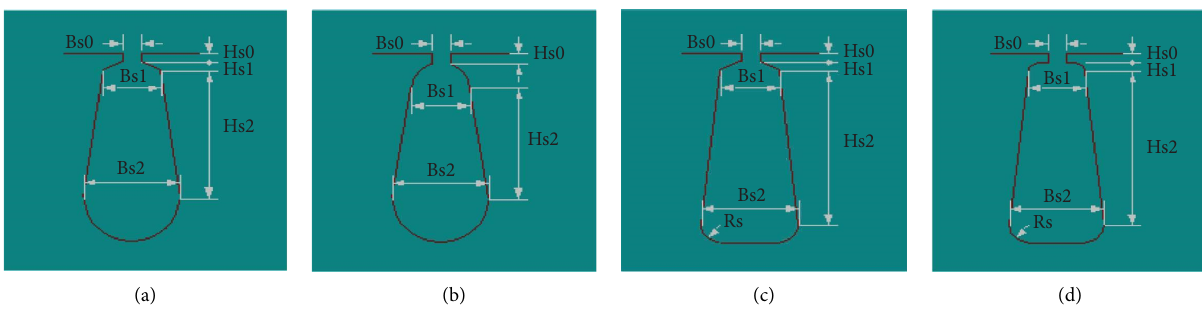
Figure 23: Four diferent types of slot patterns. (a) Pear-shaped ladder slot. (b) Pear-shaped round slot. (c) Flat-bottom ladder slot. (d) Flat- bottom round